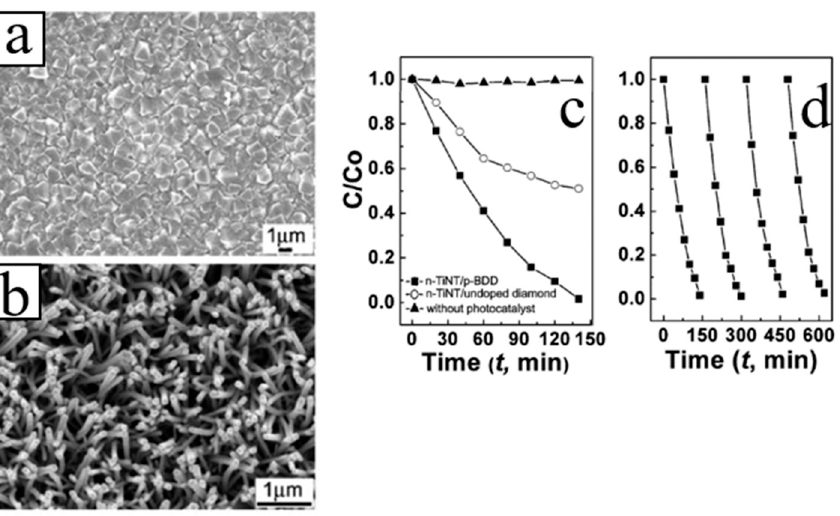
Figure 17. ( a ) SEM morphology of the BDD film; ( b ) plan-view SEM morphology of TiO 2 NTs on BDD; ( c ) photocatalytic decomposition of RY15 solution of n-TiO 2 NTs/p-BDD heterojunction, TiO 2 NTs on the undoped diamond and without photocatalyst. ( d ) Recyclability test of photocatalytic decomposition for n-TiO 2 NTs/p-BDD heterojunction [38,39].